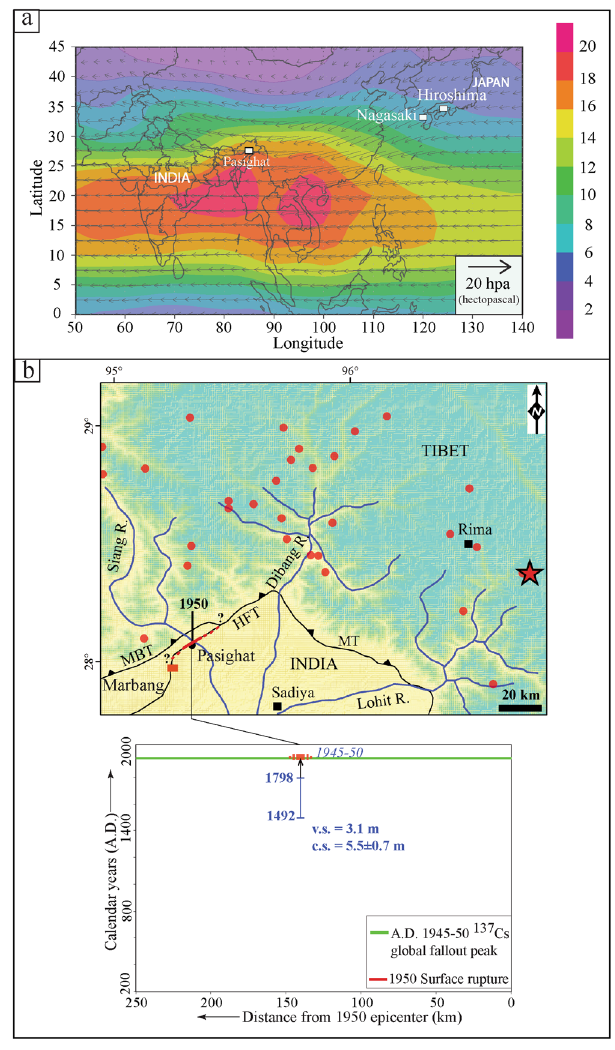
Figure 5. ( a ) Synoptic wind patterns (m/s) at 50-hpa during June 1948. Arrows indicate the wind direction; length of the arrow and color code correspond to the magnitude of the wind vector. Map was prepared in GrADS v2.0.2. software (Source: http://cola.gmu.edu/grads/). NCEP Reanalysis data provided by the NOAA/ OAR/ESRL PSD, Boulder, Colorado, USA, from their website at http://www.esrl.noaa.gov/psd ( b ) Top : Map showing the discovered earthquake surface rupture of 1950 at Pasighat and dashed line denotes uncertainty; 1950 epicenter from a previous study 15 (red star); aftershocks (red dots); major thrusts (HFT-Himalayan Frontal Thrust, MBT-Main Boundary Thrust, MT-Mishmi Thrust). Map was prepared in Arc GIS v9.3 using SRTM GTOPO 30 m imagery available at http://glcfapp.glcf.umd.edu/data/srtm/description.shtml. Bottom: Figure showing the spatiotemporal distribution of 1950 rupture event observed in the Pasighat trench (red solid line) and the uncertainty (dotted); v.s. = vertical separation; c.s. = co-seismic slip. Ages in italics denote Cs peak. Figure was designed in Adobe Illustrator CS5